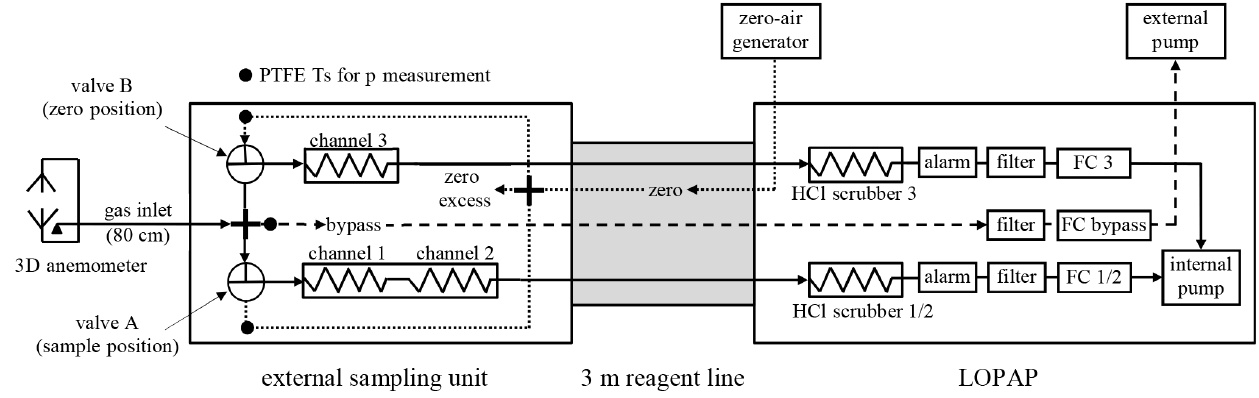
Figure 1. Gas flow scheme of the three-channel REA LOPAP.